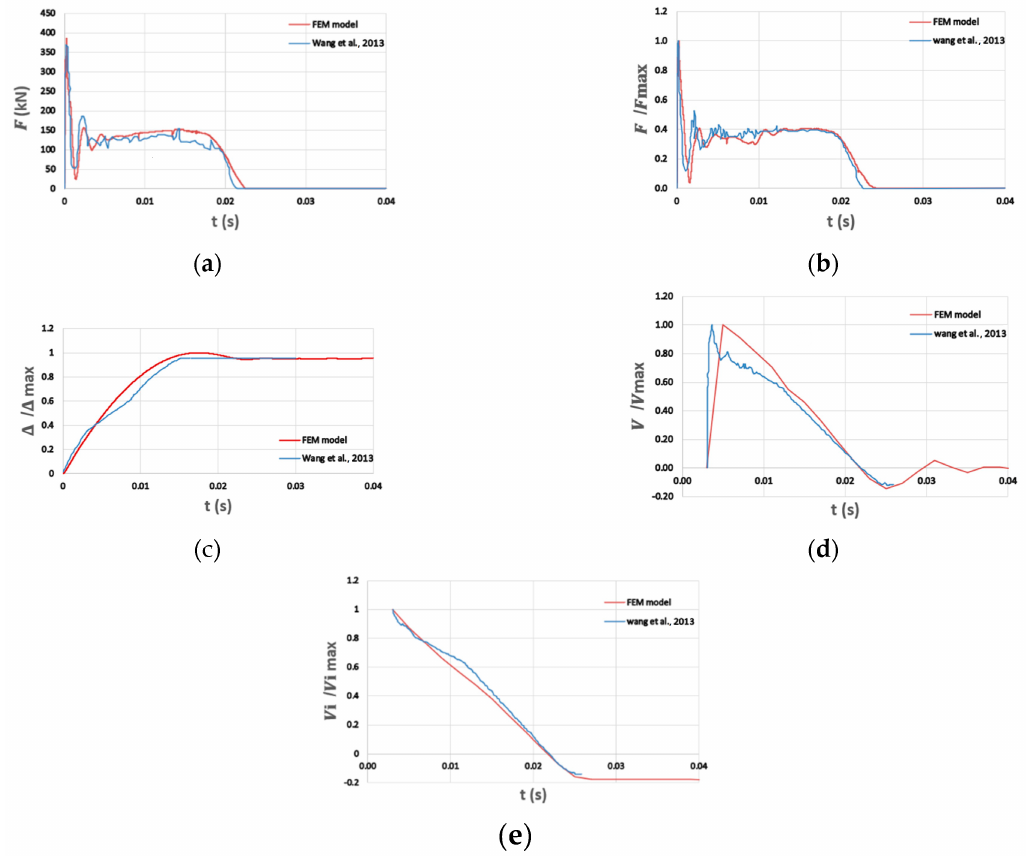
Figure 10. Results of the specimen (DZF25-114 × 3.5) Wang et al. [11]. ( a , b ) The time history of the impact force of the drop hammer curve; ( c ) time history of the mid-span deflection curve; ( d ) the mid-span velocity of the specimen; ( e ) the velocity of the drop